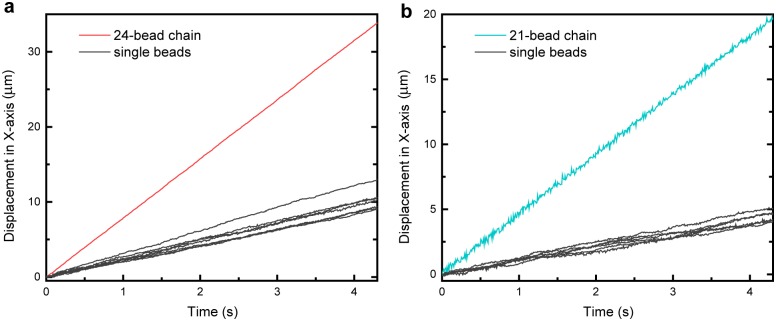
Magnetic beads and bead-chains tracking with LabVIEW program.(a): Displacement along the x-axis of the 24-bead chain from Fig 1c versus time plotted in red. Several single beads measured in the same experiment plotted in black. (b): Displacement along the x-axis of the 21-bead chain from Fig 2c versus time plotted in cyan. Several single beads measured in that same experiment plotted in black. The velocity of a given bead or bead-chain was calculated by dividing the displacement along x-axis by the time taken.